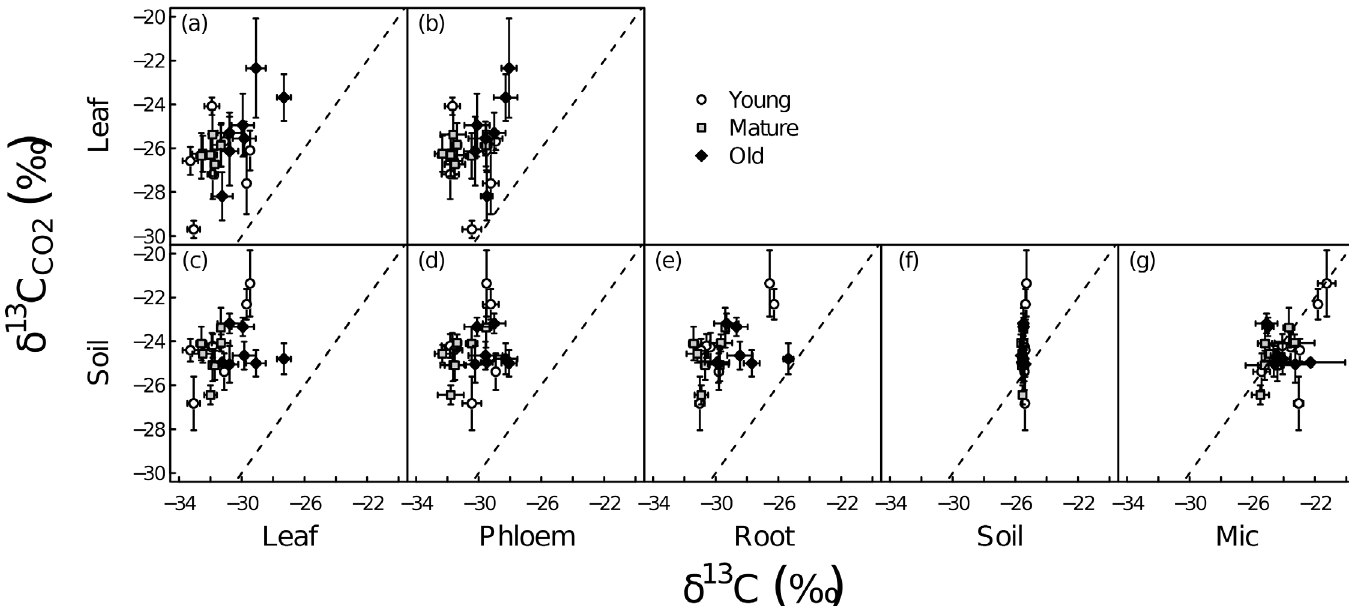
Fig 1. δ 13 C of leaf-respired CO 2 compared to δ 13 C of aboveground C pools, i.e., leaf biomass (a) and phloem sap organic matter (b), and δ 13 C of soil- respired CO 2 compared to above and belowground C pools, i.e., leaf biomass (c), phloem sap organic matter (d), root biomass (e), bulk soil (f) and microbial biomass (g) at three ontogenetic stages (young foliage, “ young ” , white circles; maximum growth rate, “ mature ” , grey squares; beginning of senescence, “ old ” , black diamonds). Each point represents the average value (n = 6) for a given plant species at a given ontogenetic stage. Errors bars indicate ± 1SE, the dashed line represents y = x.